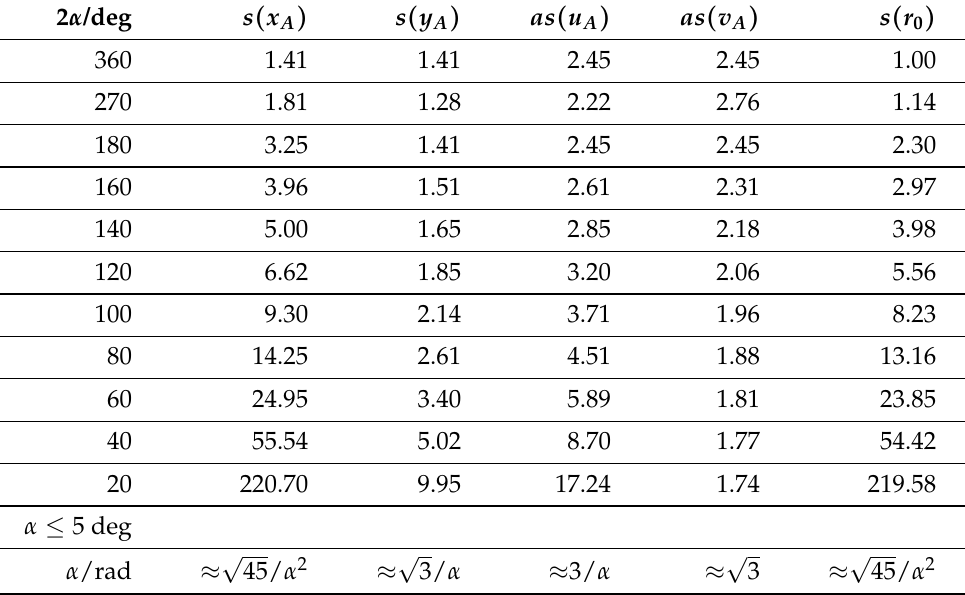
Table 5. Cylindrical patch. Square roots s ( a ) of the diagonal elements of V a α in (25). For